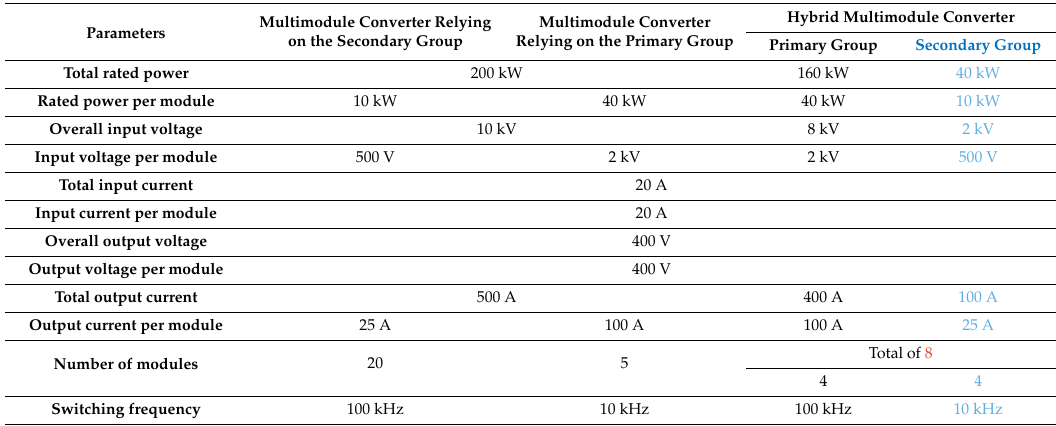
Table 3. System parameters for conventional and hybrid multimodule DC-DC